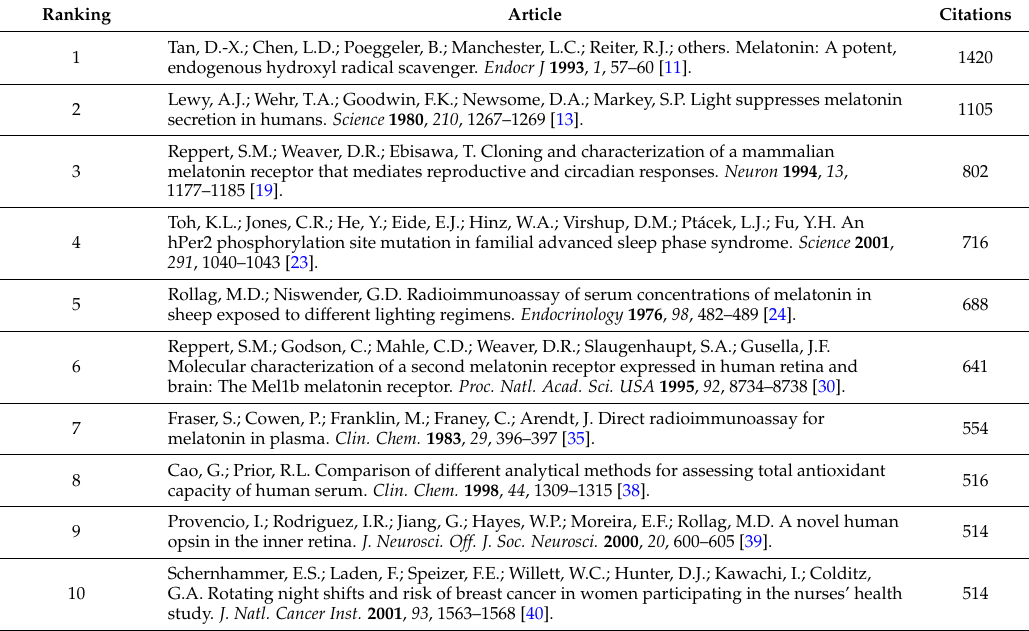
Table 4. The top 10 most cited original